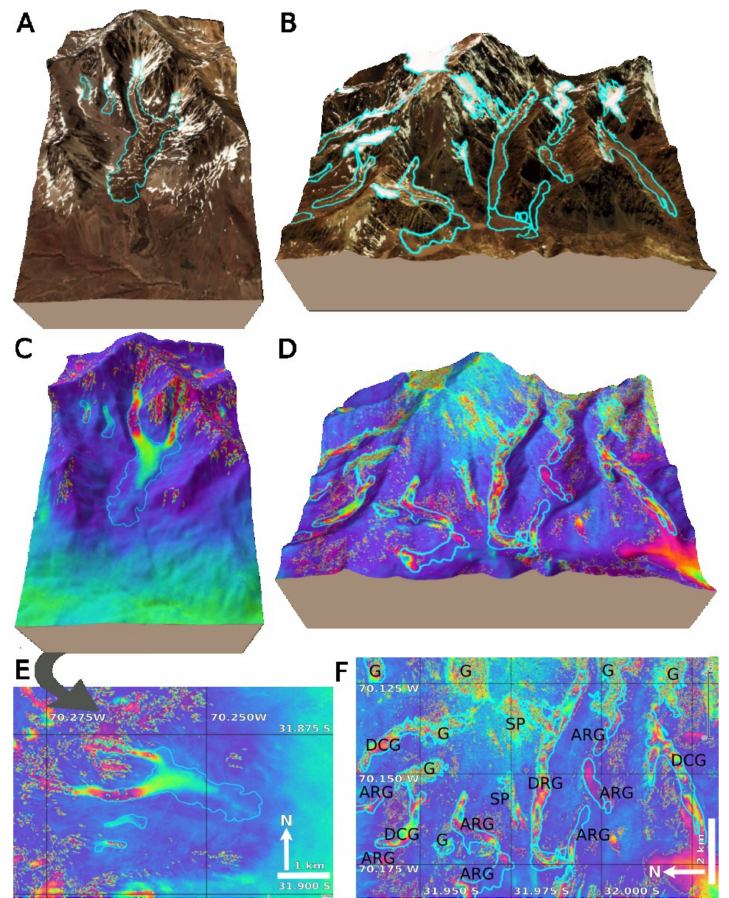
Figure 2. Identification and classification of different landforms detected in two different interferograms covering the area of the El Gigante rock glacier ( A ) and the western area of Cordon de La Ramada ( B ). The acronym meanings are: ARG: Active Rock Glacier; DCG: Debris-Covered Glacier; G: Glacier; SP: Snowpatch. ( C , D ) show the interferograms superimposed on a 3D terrain. ( E , F ) show the interferograms in 2D. Light blue polygons belong to the National Glacier Inventory